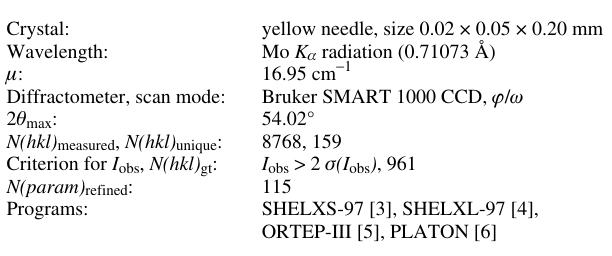
Table 1. Data collection and handling.